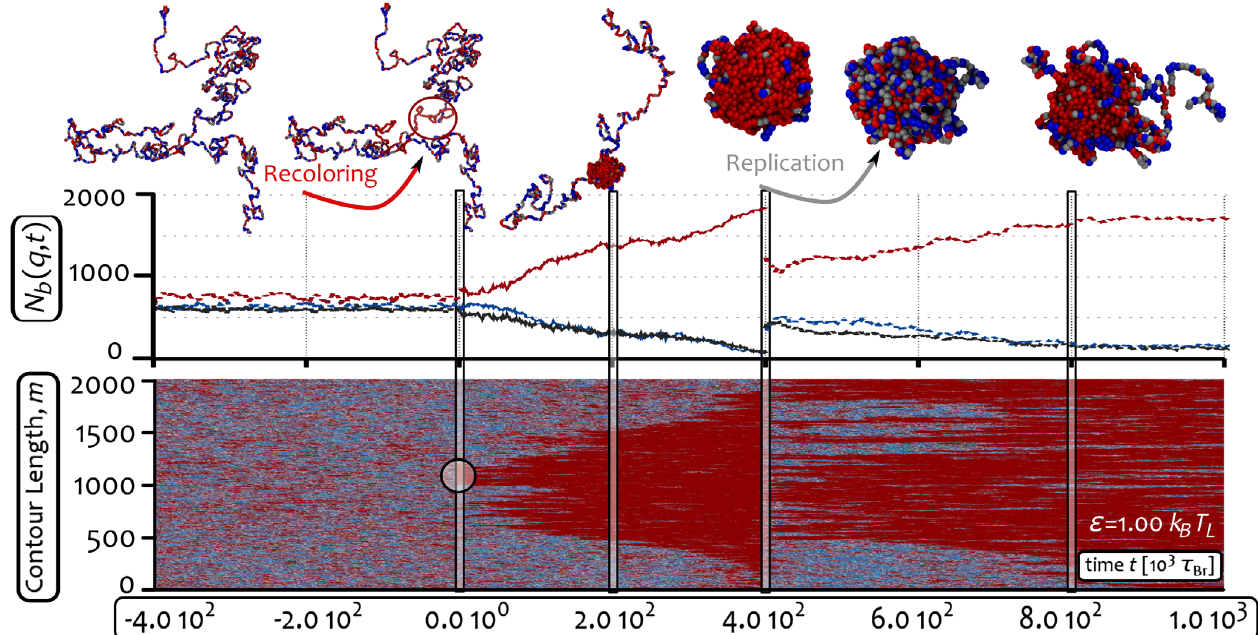
FIG. 6. The two-state – with – intermediate-state model displays ultrasensitive response to external signals such as replication or chromosome inactivation. We show the time evolution of the system starting from a mixed metastable state (MMS) and for ϵ ¼ k t ¼ 0 , a localized perturbation of the MMS is externally imposed by recoloring a segment of 200 beads (10% of the polymer length). This perturbation triggers the collapse of the whole chain into an epigenetically coherent state that is reached within about 4 10 5 Brownian times. At t ¼ 4 10 5 τ , we next simulate semiconservative replication of the collapsed chromatin fiber. This is achieved by Br assigning a random color to 50% of the beads all along the polymer. Following this extensive (i.e., nonlocal) color perturbation, the polymer returns to the epigenetically ordered phase. These results show that the epigenetically coherent phase is robust and stable with respect to extensive perturbations, in stark contrast to the much more sensitive MMS. Movie M4 in Ref. [54] shows the whole dynamics. Contact maps are shown in Ref. [54], Fig.